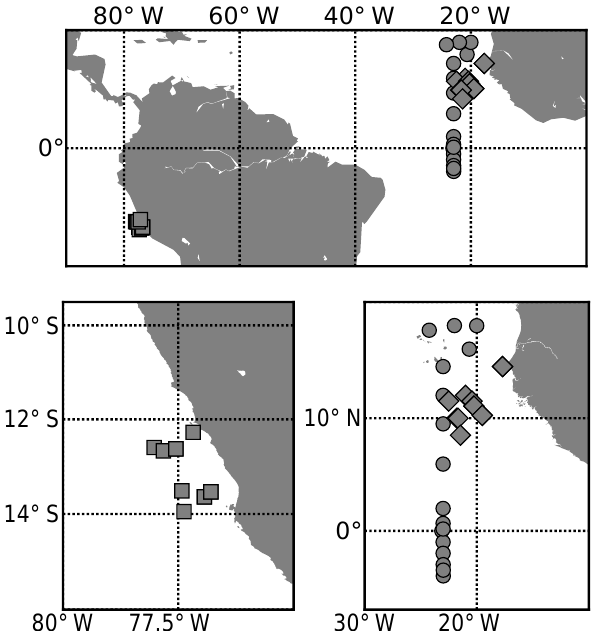
Figure 1. Sampling locations of specimens for respiration and excretion measurements. Circles: Pleuromamma abdomi- nalis and Undinula vulgaris during cruise MSM22 (Octo- ber/November 2012); Squares: Euphausia mucronata during cruise M93 (February 2013); Diamonds: Euphausia gibboides during cruise M97 (May